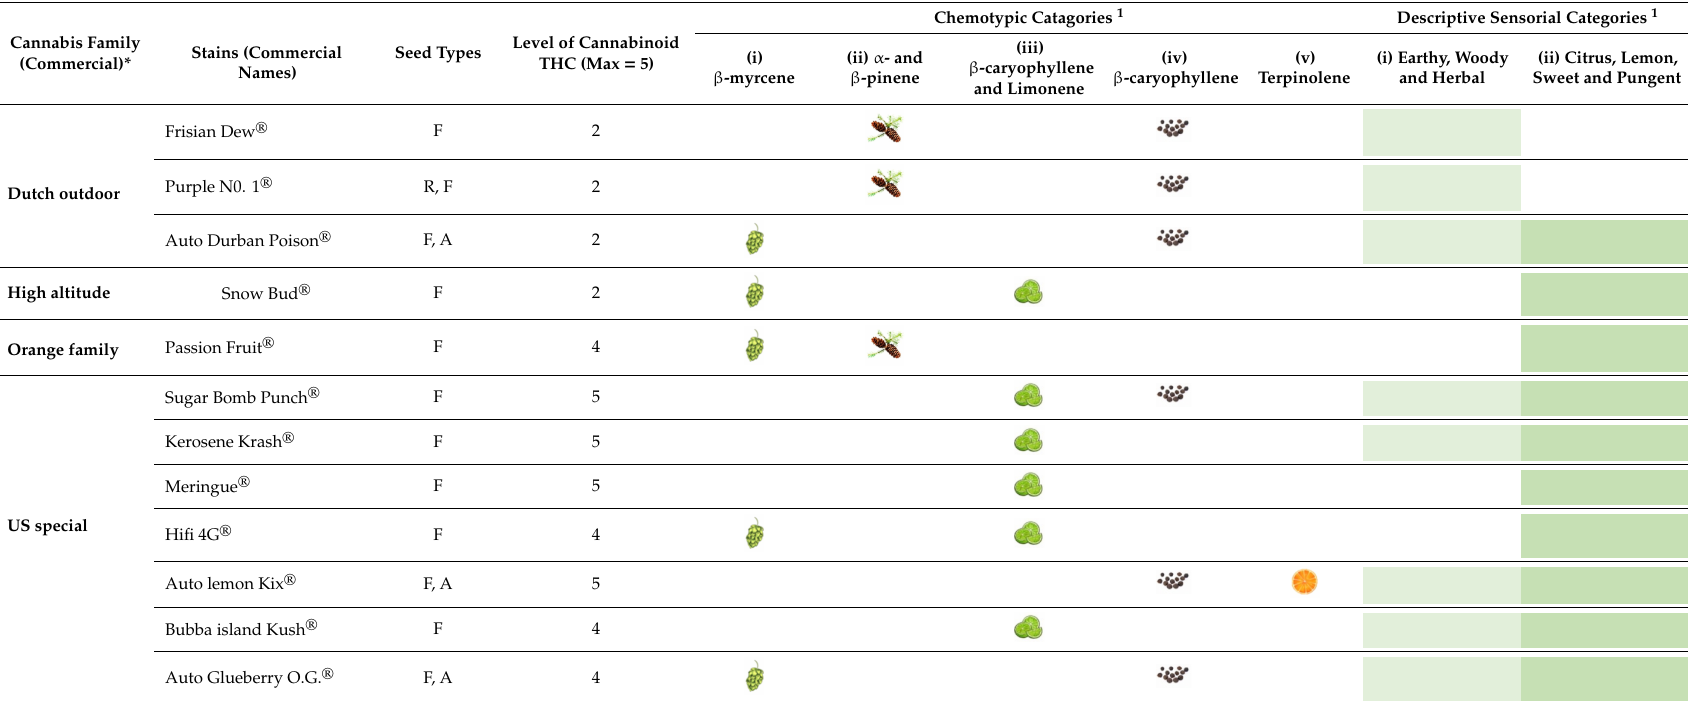
Table 3. Terpene profile category of di ff erent commercial cannabis